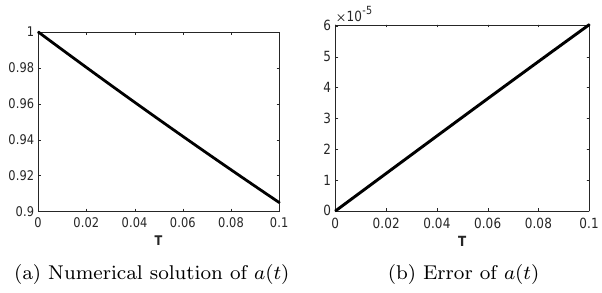
Figure 1. Numerical solution and the error of a ( t ) for t ∈ [0 ,T ] in example 1. α = 1 . 9, T = 0 . 1 and ∆t = 10 − 4 are used. We can see that the error of a ( t ) increases as t increases. The numerical re- sults also show that the the absolute maximum error of a is 6 . 0411 × 10 − 5 , which indicates that our numerical method can recover the function a ( t )